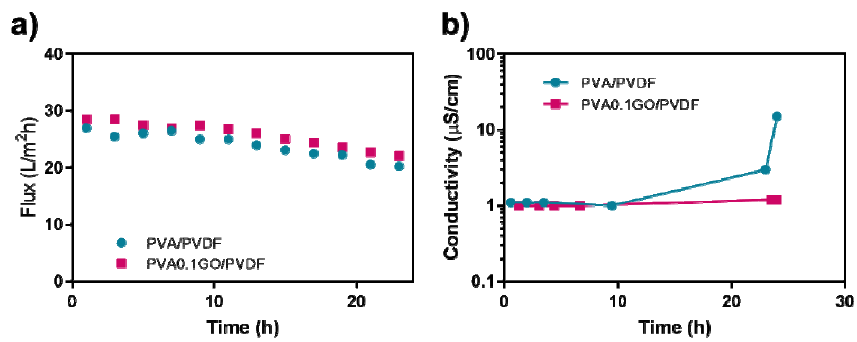
Figure 21. ( a ) Flux and ( b ) permeate conductivity profiles of composite PVA/PVDF membrane (MR